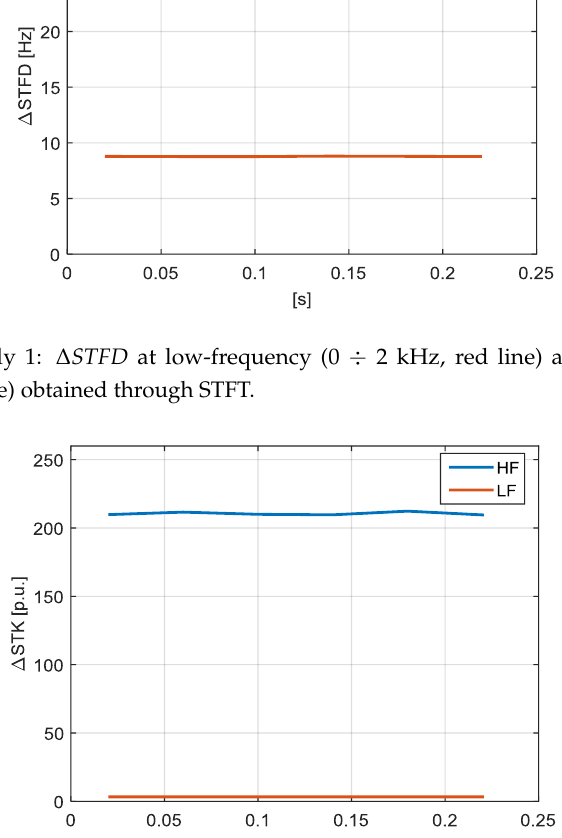
Figure 28. Case study 1: STDE at low-frequency (0 ÷ 2 kHz, red line) and at high-frequency (2 ÷ 150 kHz, blue line) obtained through Prony’s method. Figure 29. Case study 1: Δ STFD at low-frequency (0 ÷ 2 kHz, red line) and at high-frequency (2 ÷ 150 kHz, blue line) obtained through Prony’s method.